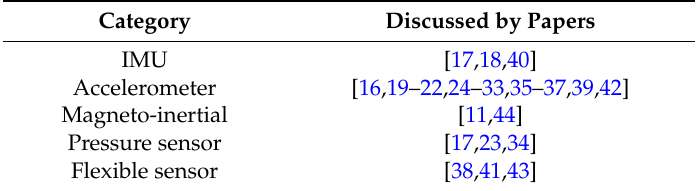
Table 3. Statistical representation of sensors selection for infant movement